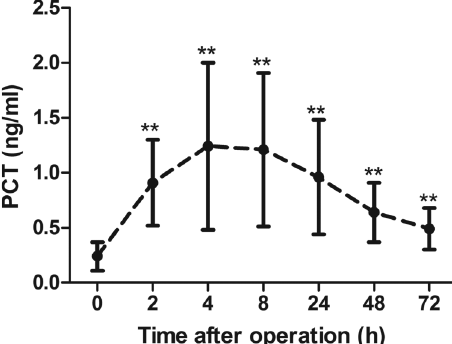
Figure 2 - Dynamic changes in PCT levels post-tracheotomy in all patients. Data are presented as the mean ± SD. The PCT levels increased immediately after tracheotomy and gradually decreased thereafter. PCT: procalcitonin. ** p o 0.001 vs. T0, obtained using an